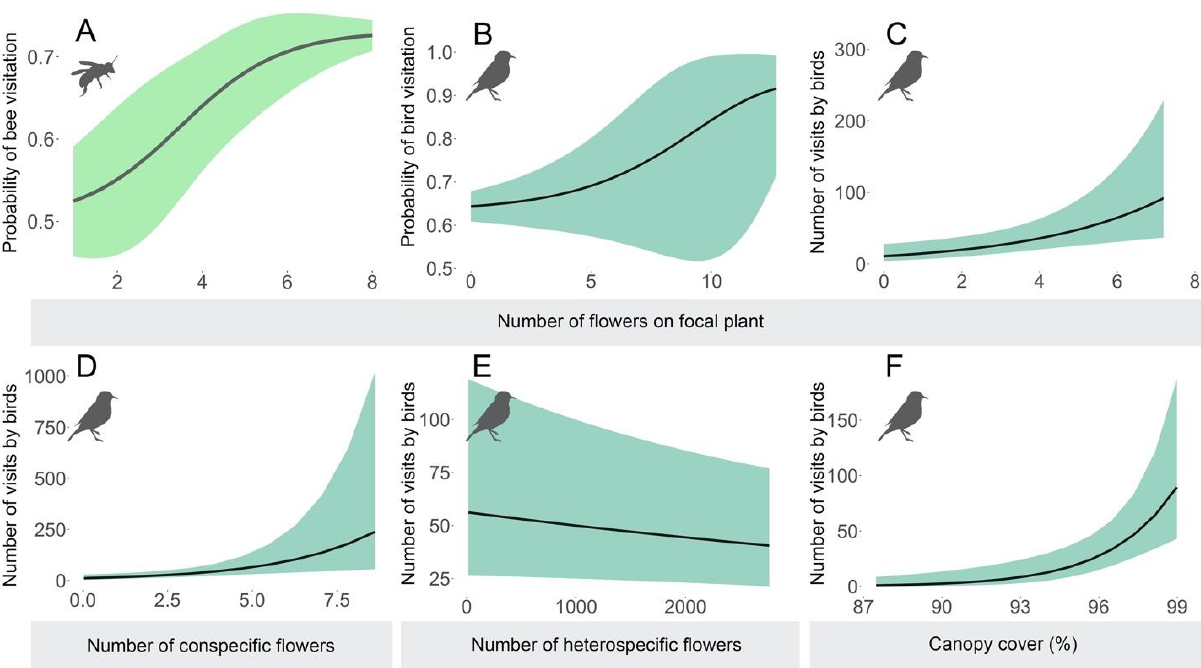
Figure 2. Model results from bird and bee visitation models, with the number of flowers on the focal plant affecting (A) the probability of bee visitation, (B) the probability of bird visitation, and (C) the number of visits by birds. The number of visits by birds was influenced by (D) the number of conspecific flowers, (E) the number of heterospecific flowers, and (F) the percentage of canopy cover. The green shading is the 95% CIs from the model